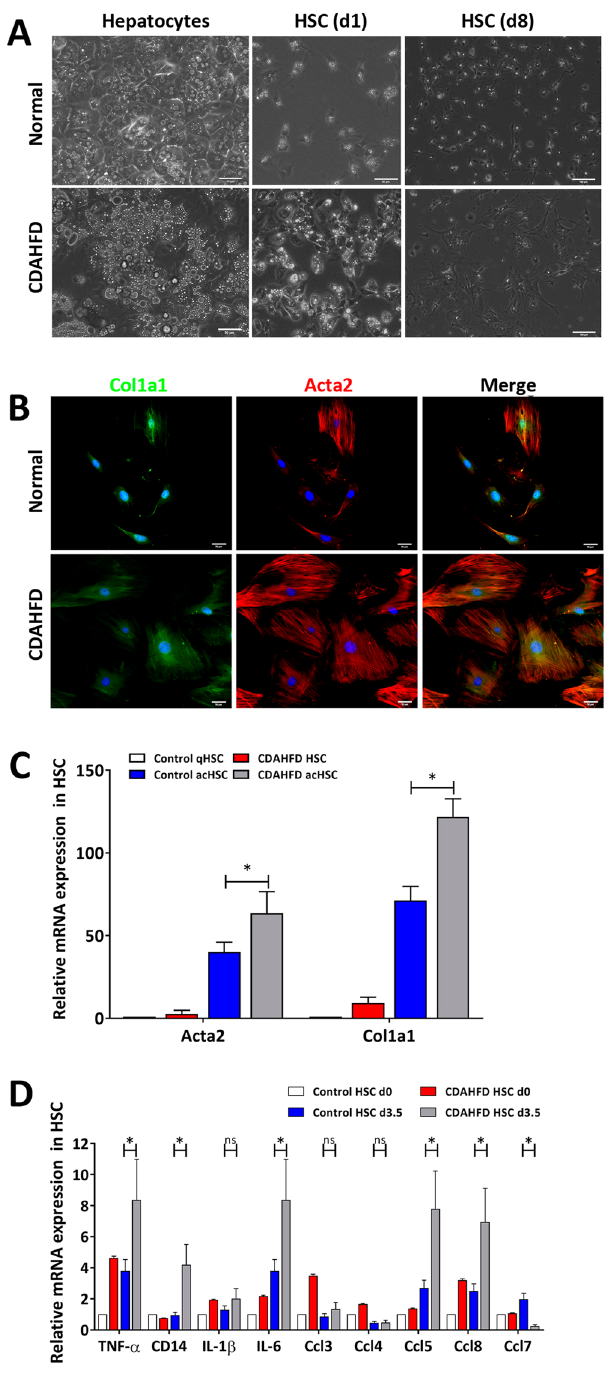
Figure 2. Hepatic stellate cells from mice with steatohepatitis induced by CDAHFD are primed to become activated. ( A ) Hepatocytes from mice with CDAHFD induced steatohepatitis were steatotic while hepatic stellate cells were only slightly larger in size compared to those from healthy mice. After eight days of culture, hepatic stellate cells from early NASH became much larger in size compared to control stellate cells. ( B ) Hepatic stellate cells from mice with CDAHFD induced steatohepatitis more quickly increased in size and in expression of activation markers Colla1 and Acta2, visualized here just three days after the initial cell isolation. ( C ) Hepatic stellate cells from mice with CDAHFD induced steatohepatitis maintained higher expression of Col1a1 and Acta2 than those from control mice even after both populations were fully activated on plastic dish. Expression levels measured with qPCR. ( D ) Hepatic stellate cells from mice with CDAHFD induced steatohepatitis had elevated expression of several pro-inflammatory cytokines compared to those from control mice. Expression levels measured with qPCR. All data are presented as mean + / − SD ( * P < 0.05). NASH, non-alcoholic steatohepatitis; CDAHFD, choline-deficient L-amino acid defined high fat diet; HSC, hepatic stellate cell; qHSC, quiescent hepatic stellate cell; acHSC, activated hepatic stellate cell; Col1a1, alpha-1 type I collagen; Acta2, alpha smooth muscle actin; ns, not